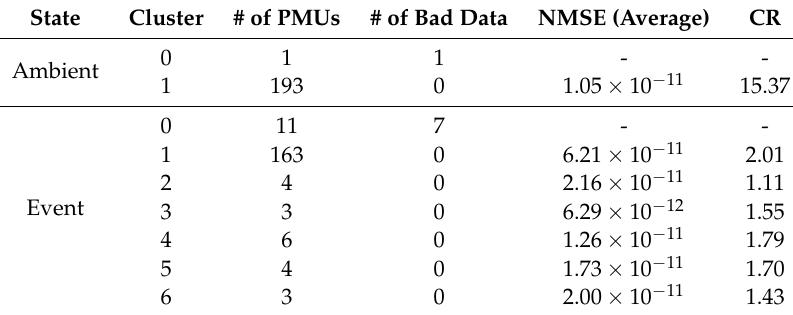
Table 3. MSPCA compression of clustered data